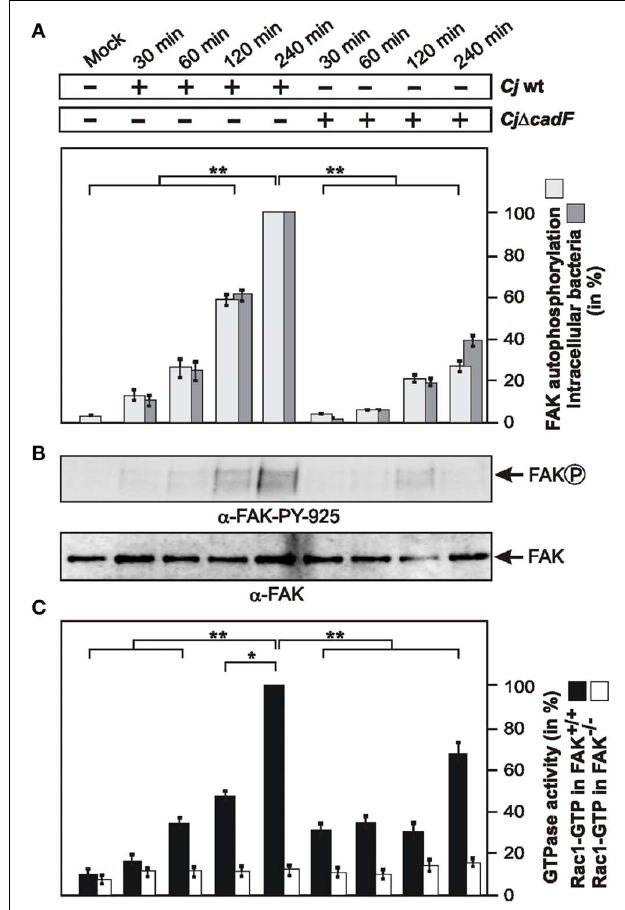
FIGURE 4 | Importance of FAK for C. jejuni -induced Rac1 activation and role of the bacterial CadF protein. (A) FAK-positive fibroblasts were infected withWT C. jejuni F38011 or isogenic F38011 Δ cadF for indicated periods of time. Quantification of FAK kinase activity during the course of infection. One hundred percentage of activity corresponds to the highest amount of detected FAK phosphorylated atY-397 (lane 5). (B) Cell lysates were also analyzed by immunoblotting with α -FAK-PY-925.Total FAK expression levels were determined as control. (C) Quantification of Rac1 GTPase activity during the course of infection. FAK-positive and FAK-deficient cells were infected with C. jejuni WT F38011 or F38011 Δ cadF mutant for the indicated periods of time.The presence of bound, active Rac1-GTP or was analyzed in CRIB–GST pull-down assays. One hundred percentage of activity corresponds to the highest amount of detected GTPase-GTP level. ∗ p < 0.05 and ∗∗ p ≤ 0.005 were considered as statistically significant as compared to the